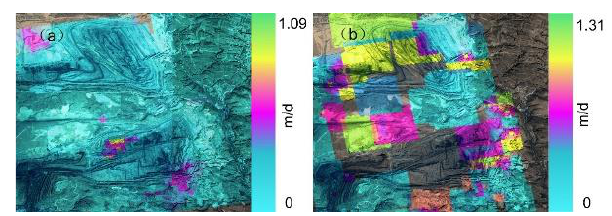
Figure 5. Offsets velocity distribution in the study area